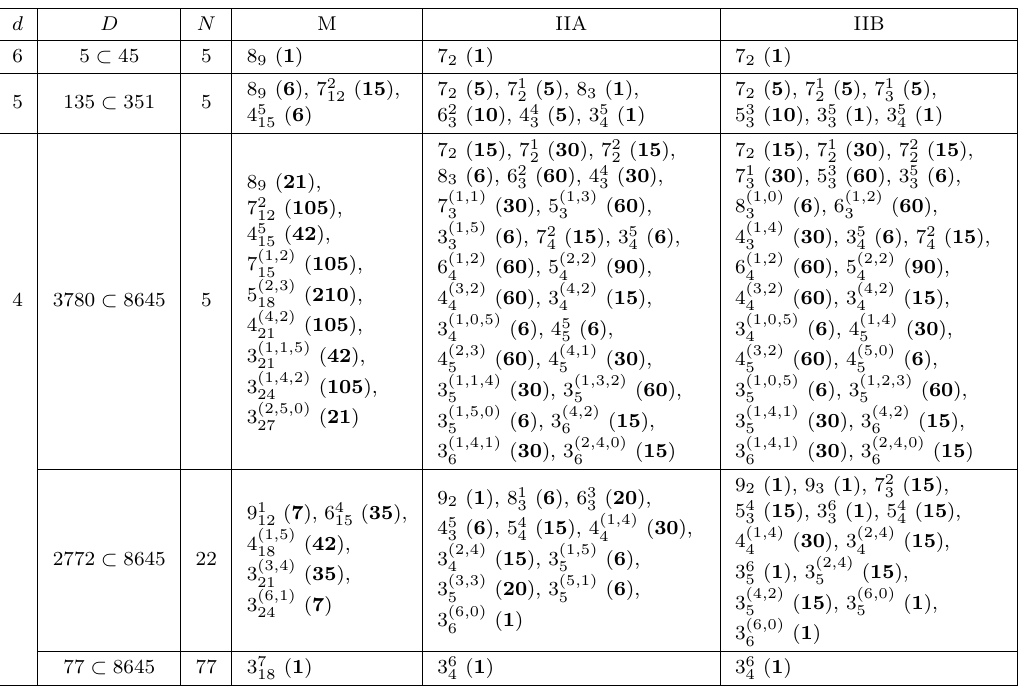
Table 18 . Missing states in the 3-brane